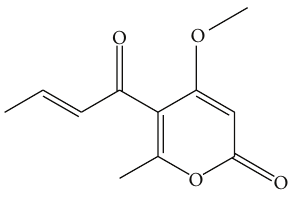
Figure 1: Structure of pyrenocine A produced in culture by the marine-derived fungus Penicillium paxilli